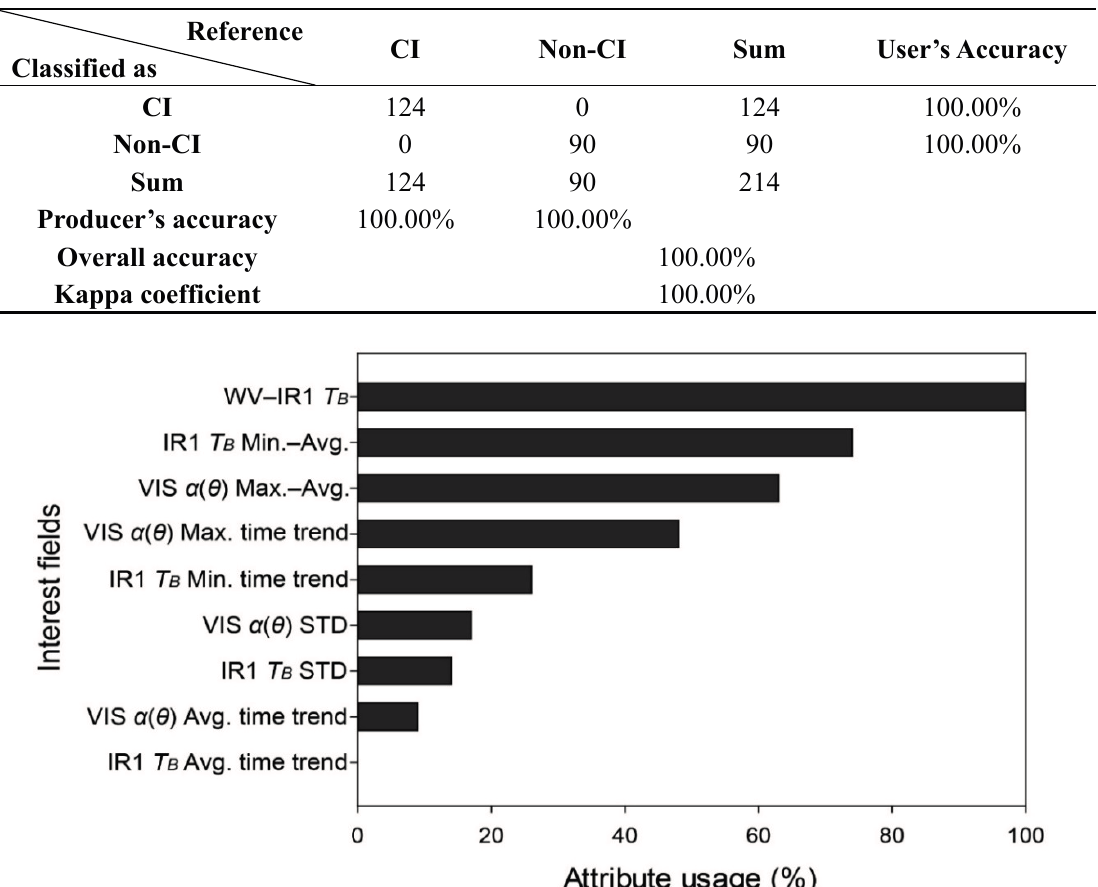
Table 6. Accuracy assessment results for the SVM model using the test dataset